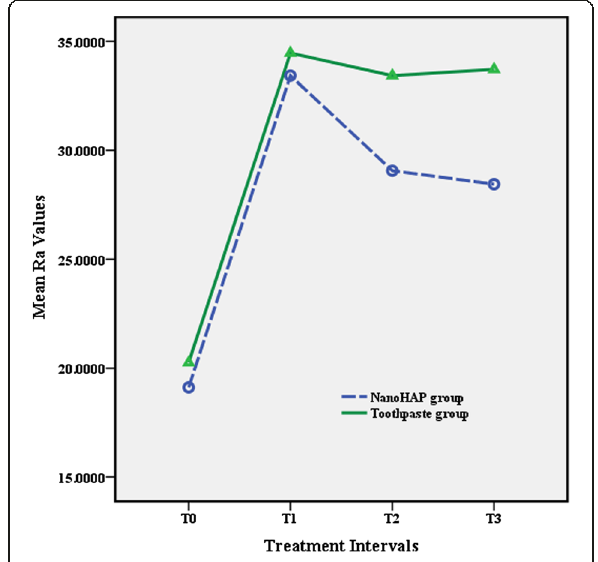
Fig. 5 Results of maximum peak-to-valley height ( R z